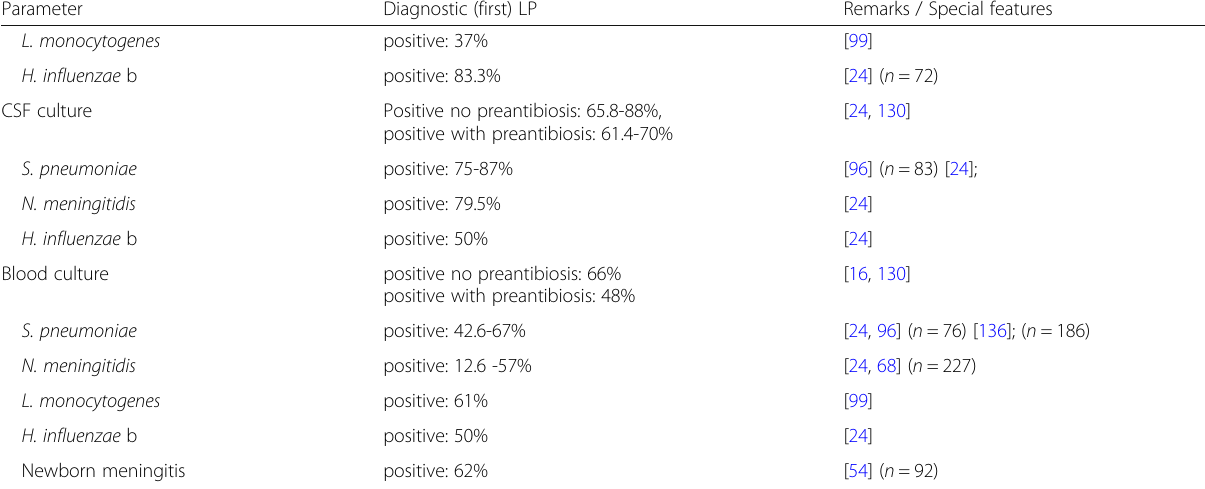
Table 5 Overview of diagnostically relevant routine parameters in acute bacterial meningitis (BM) and frequency of “ typical ” and “ atypical ” changes depending on the bacterial pathogen (Continued)